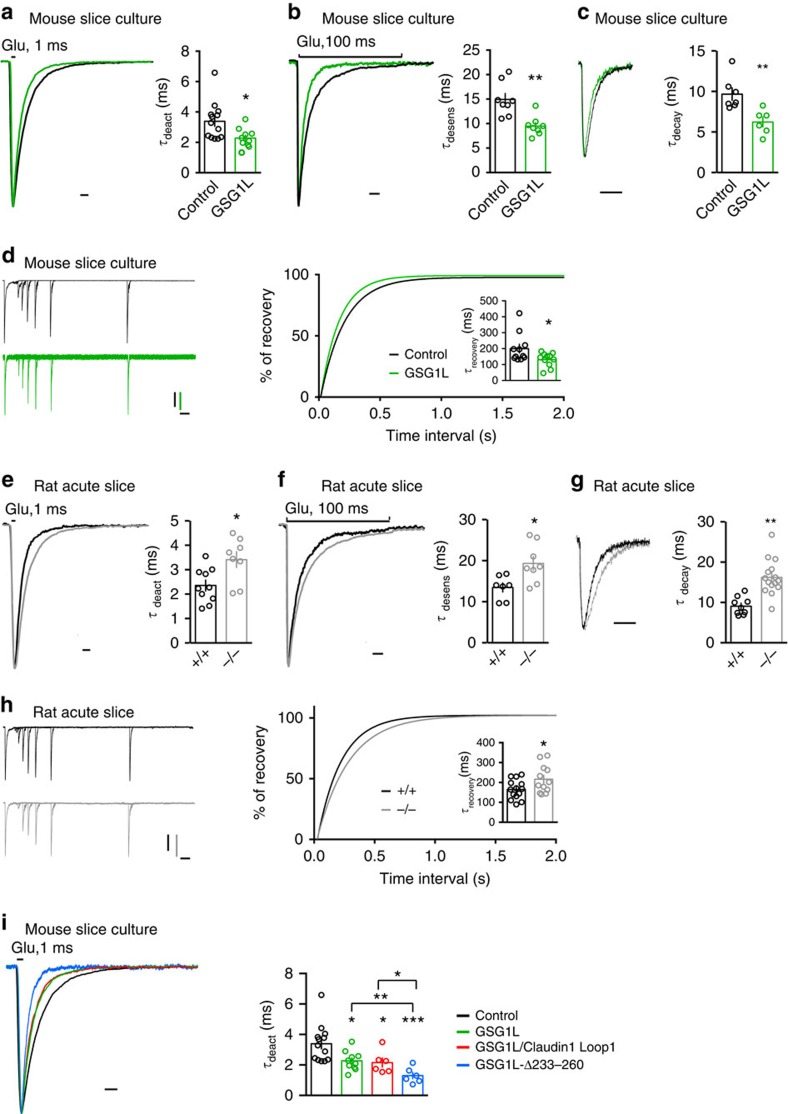
GSG1L modulates AMPAR kinetic properties in CA1 pyramidal neurons.(a–c) GSG1L overexpression in cultured organotypic
hippocampal slices sped up AMPAR deactivation time constant (a,
control, n=13; GSG1L, n=10; P<0.05;
t-test; Scale bar, 2 ms), desensitization time constant
(b, control, n=8; GSG1L, n=8;
P<0.01; t-test; Scale bar, 10 ms) and mEPSC
decay time constant (c, control, n=7; GSG1L,
n=6; P<0.01; t-test; Scale bar, 20 ms)
in CA1 pyramidal neurons. Peak-normalized sample traces are shown to the
left for a–c. (d) GSG1L overexpression modestly
accelerated the recovery of AMPARs from desensitization (control,
n=11; GSG1L, n=11; P<0.05;
t-test). Scale bar, 100 ms, 200 pA (black) and
20 pA (green). (e–g) In GSG1L KO CA1 pyramidal
neurons, AMPAR deactivation time constant (e, +/+,
n=10; −/−, n=8; P<0.05;
t-test; Scale bar, 2 ms), desensitization time constant
(f, +/+, n=7; −/−,
n=8; P<0.05; t-test; Scale bar, 10 ms)
and mEPSC decay time constant (g, +/+, n=9;
−/−, n=15; P<0.01; t-test; Scale
bar, 20 ms) were significantly slowed. Peak-normalized sample traces
are shown to the left for e–g. It is worth noting that
our overexpression experiments (a–d) were performed in
mouse slice cultures and gene KO experiments (e–h) were
performed in acute rat slices. Thus, the τ values for
deactivation and desensitization in rat or mouse CA1 control neurons are
different, but are consistent with published data102224596768. (h) GSG1L KO modestly slowed the
AMPAR recovery from desensitization (+/+, n=14;
−/−, n=12; P<0.05; t-test). Scale
bar, 100 ms, 100 pA (black) and 100 pA (grey).
(i) Deletion of the juxtamembrane region in the GSG1L C
terminus-accelerated AMPAR deactivation kinetics (control,
n=13; GSG1L, n=10; GSG1L/Claudin1 Loop1,
n=6; GSG1L-Δ233–260, n=6;
One-way ANOVA test P<0.05, P<0.01, P<0.001).
Peak-normalized sample traces are shown to the left. Scale bar, 2 ms.
Statistical significance is presented as *P<0.05,
**P<0.01 or ***P<0.001.